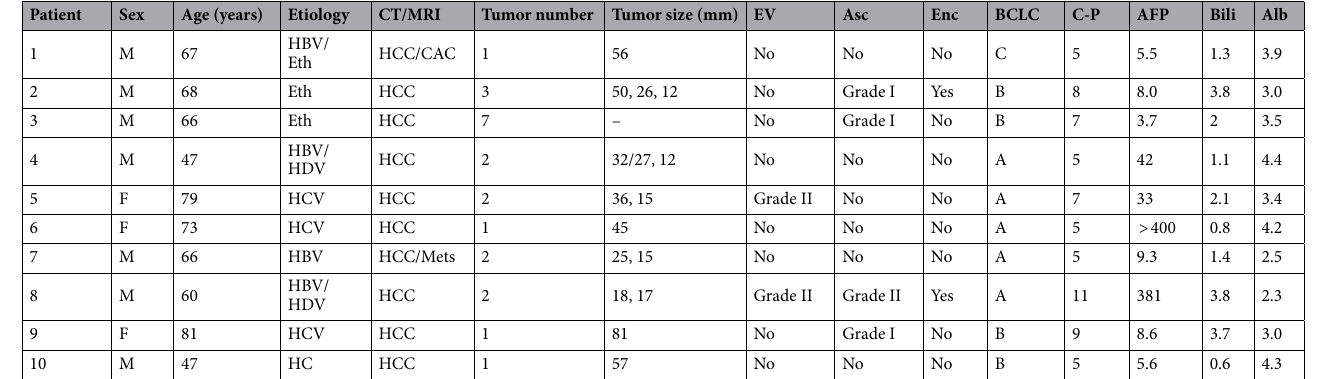
Table 1. Hepatocellular carcinoma patient details. HBV hepatitis B virus, Eth ethanol,, HDV hepatitis D virus, HCV hepatitis C virus, HC hemochromatosis, HCC hepatocellular carcinoma, CAC cholangiocarcinoma; Mets , metastases, EV esophageal varices, Asc ascites, Enc encephalopathy, BCLC Barcelona clinic liver cancer staging, C-P Child–Pugh score, AFP alpha-fetoprotein (ng/mL), Bili total bilirubin (mg/dL), Alb albumin (g/dL), UK unknown, Dysp Nod dysplastic nodules.